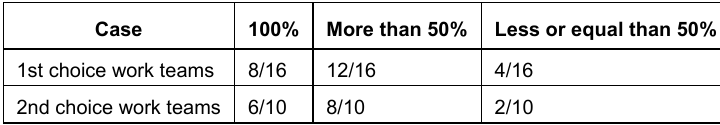
Table 9. Correspondence percentages for work teams using the consensus Case 100% More than